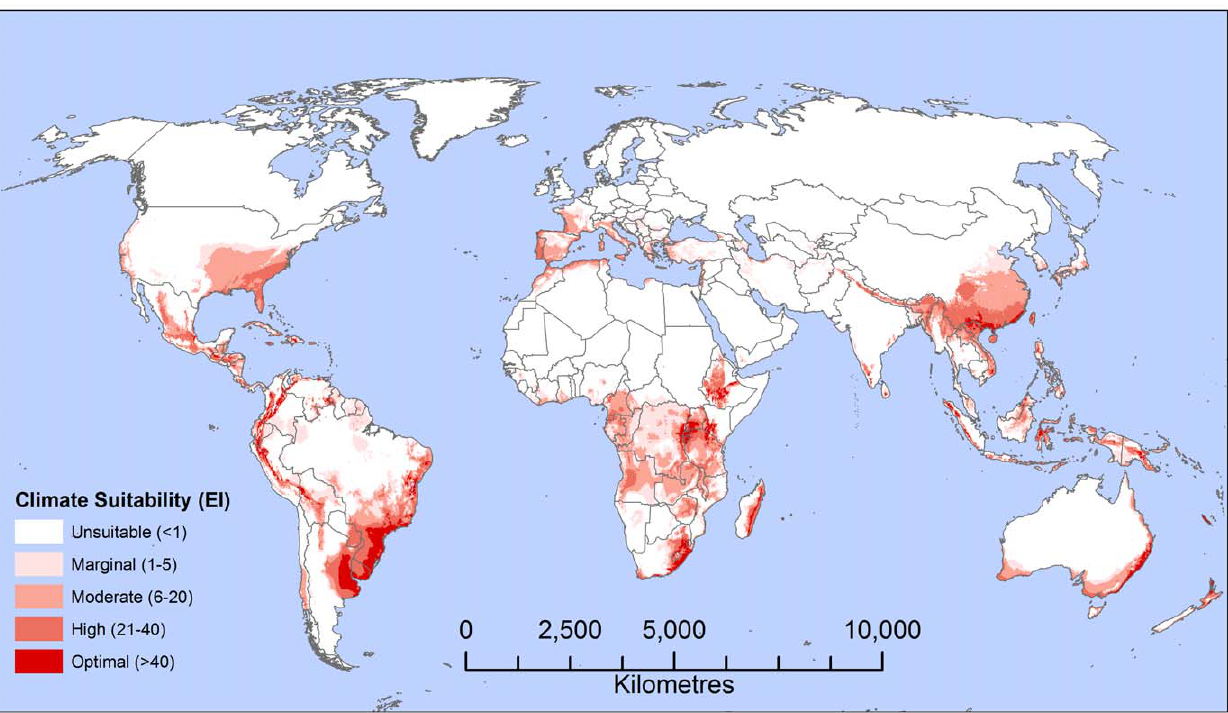
Figure 5. Global climate suitability for Thaumetopoeapityocampa modelled using CLIMEX Ecoclimatic index (EI). Projection: Robinson.